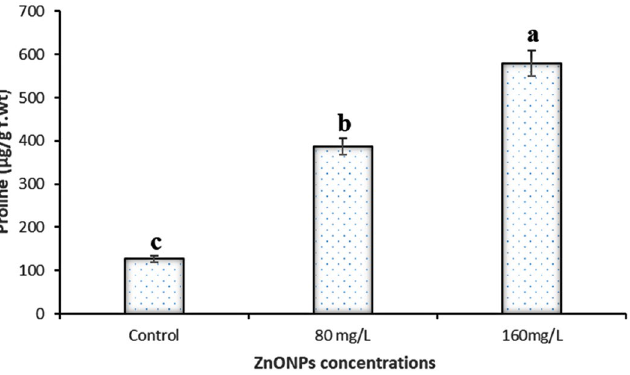
Figure 4. The effect of different concentrations of ZnO nanoparticles on proline in callus of J. procera.